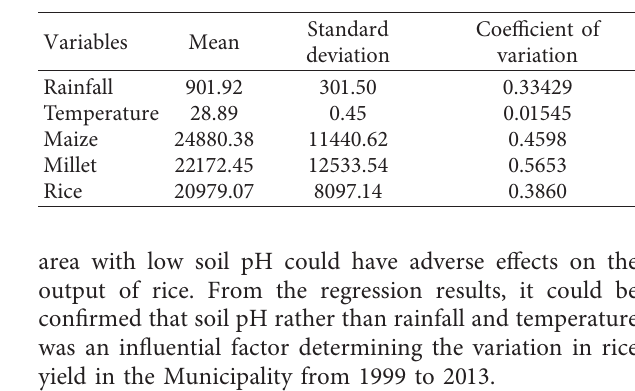
Table 5: Summary statistics of climate variables and major